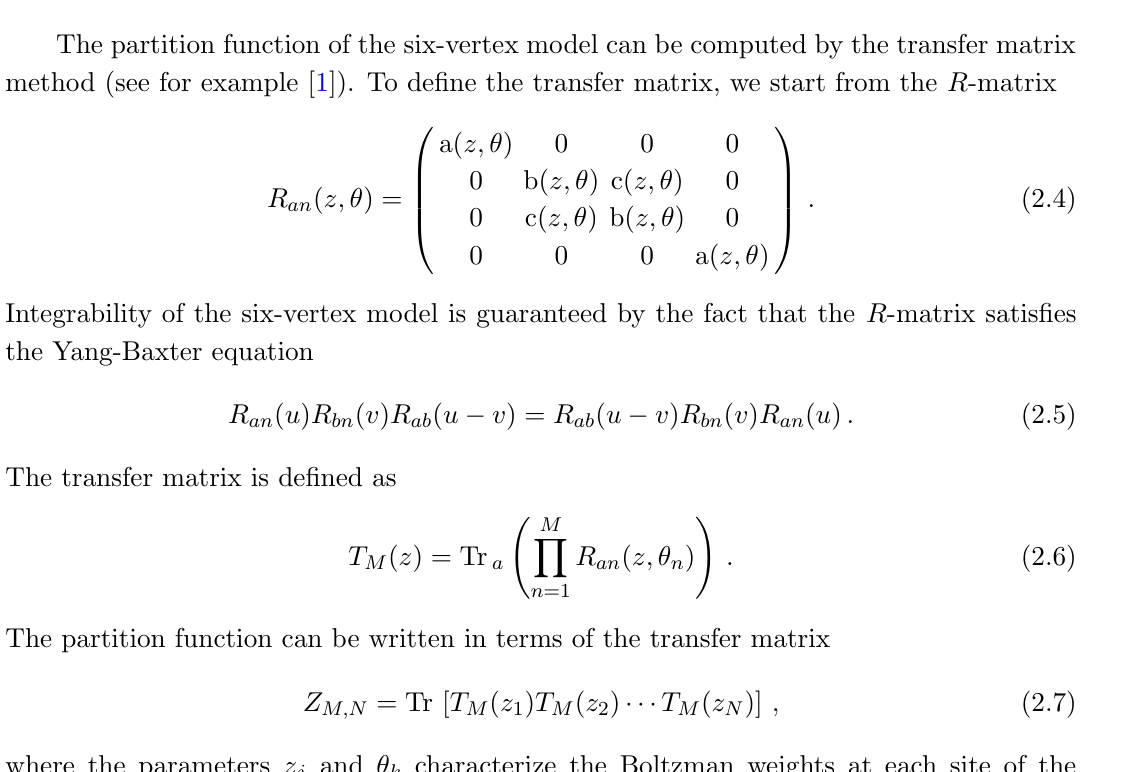
Figure 2 . One possible con(cid:12)guration for the six-vertex model of size M (cid:2) N